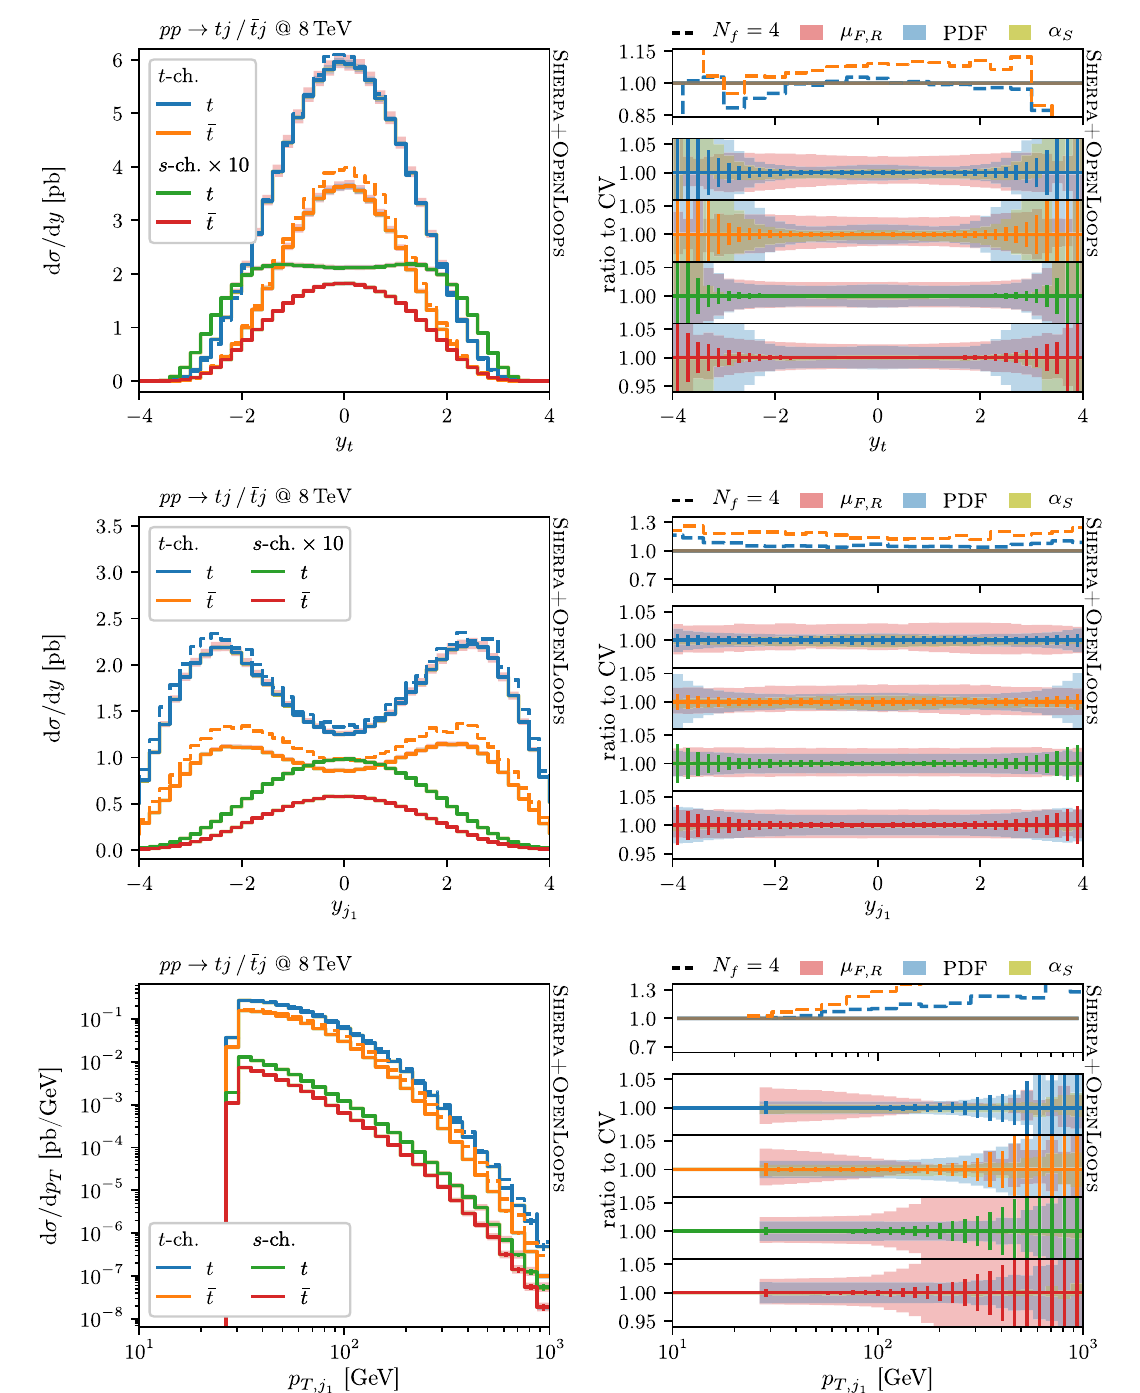
Fig. 3 The plots in the left panel show the distribution of the top- nel: t -channeltop(blue)andanti-top(orange),and s -channeltop(green) and antitop-quark rapidity y t (top) as well as the leading-jet rapidity and anti-top (red) production. The additional panel at the top of each y j uncertainty breakdown shows the ratio of the four-flavour scheme cal- (centre) and its transverse momentum p T , j (bottom) for leptonic 1 1 t - and s -channel single-top production in the five-flavour scheme. No culation (dashed) to the corresponding five-flavour calculation (solid) for t -channel production. Note that the s -channel rapidity distributions additional phase-space cuts apply. The plots in the right panel detail have been scaled by a factor of ten. Also note the varying y ranges of their respective uncertainties stemming from the choice for the scales the flavour-scheme ratio (red band), parton distributions (blue band) and the value of α s (yellow band). Each such uncertainty budget is shown separately for each chan-